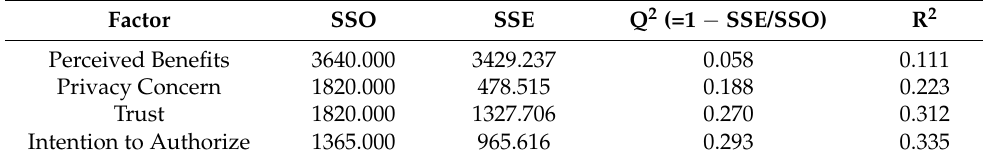
Table 6. Results of Q 2 values and R 2